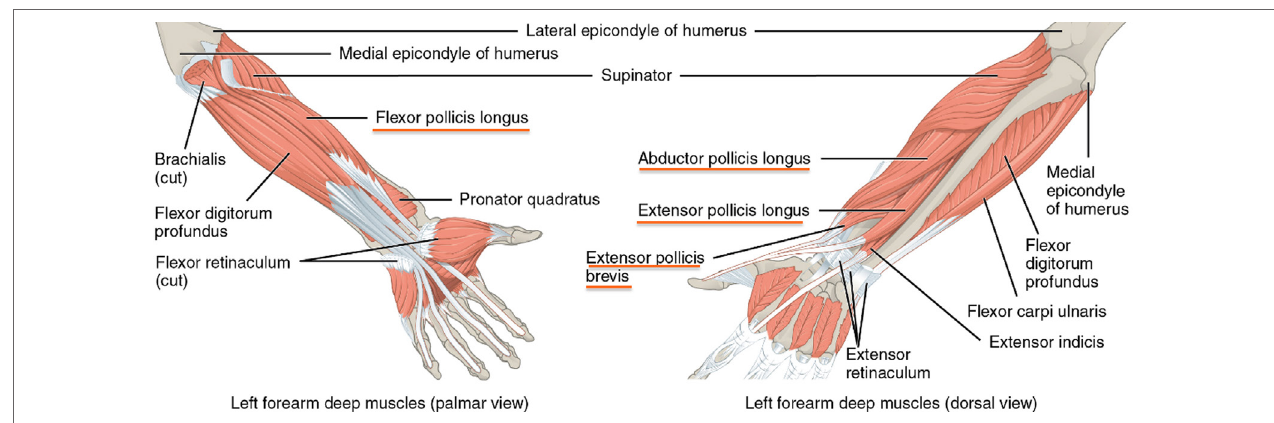
FiGURe 3 | Extrinsic muscles in the hand [https://www.lecturio.com/magazine/musculature-forearm-hand/ (Last accessed: 7/10/2016). Image credit: “Muscles That Move the Forearm” by Phil Schatz. License: CC BY 4.0 (https://creativecommons.org/licenses/by/4.0/deed.en)]. Four extrinsic muscles (see underlined) control the thumb through the